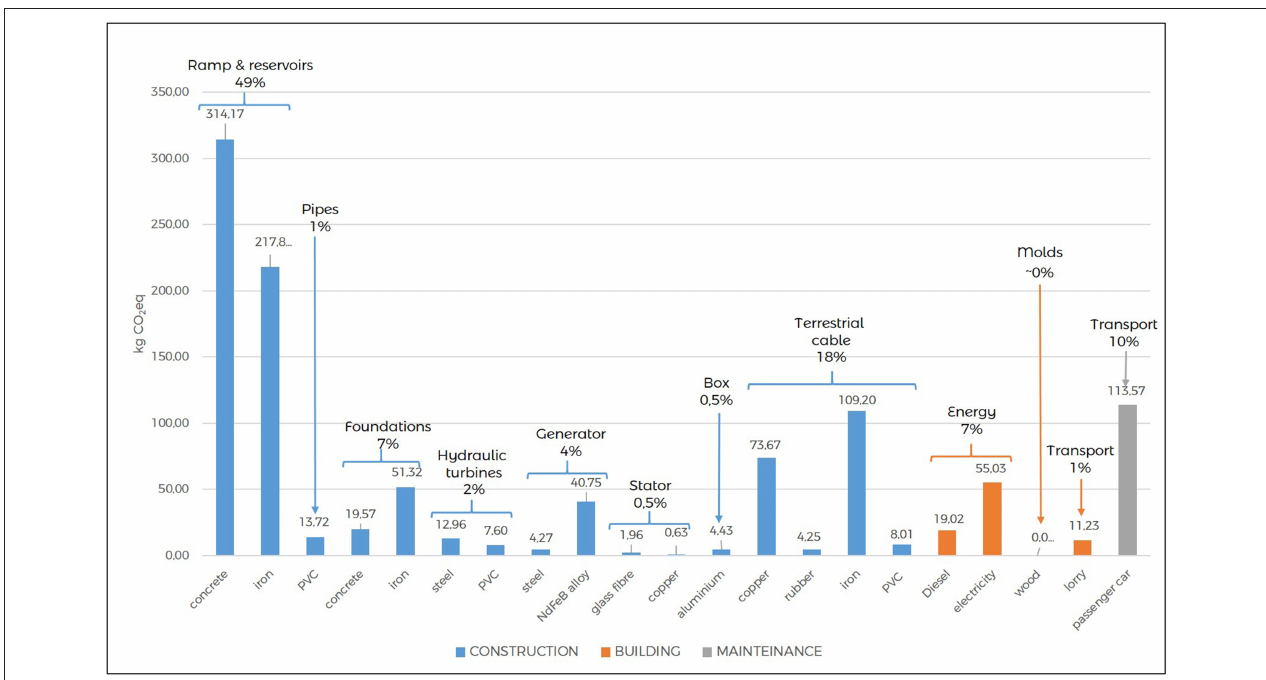
FIGURE 3 | Breakdown of the CF of the OBREC module by single input flows (bottom). The percentage contribution of each construction element is reported in detail (up). Colors represent three Life Cycle Phases (Legend: blue = construction; orange = building; gray = maintenance).